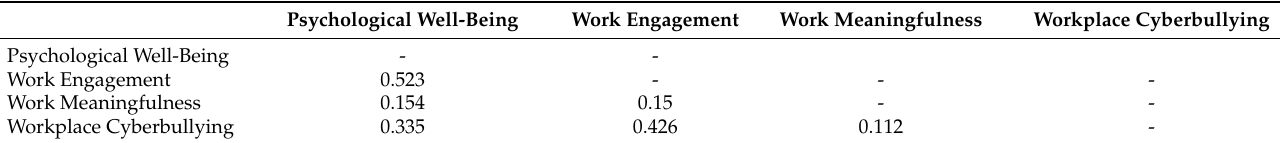
Table 3. Heterotrait–Monotrait (HTMT) ratio for the